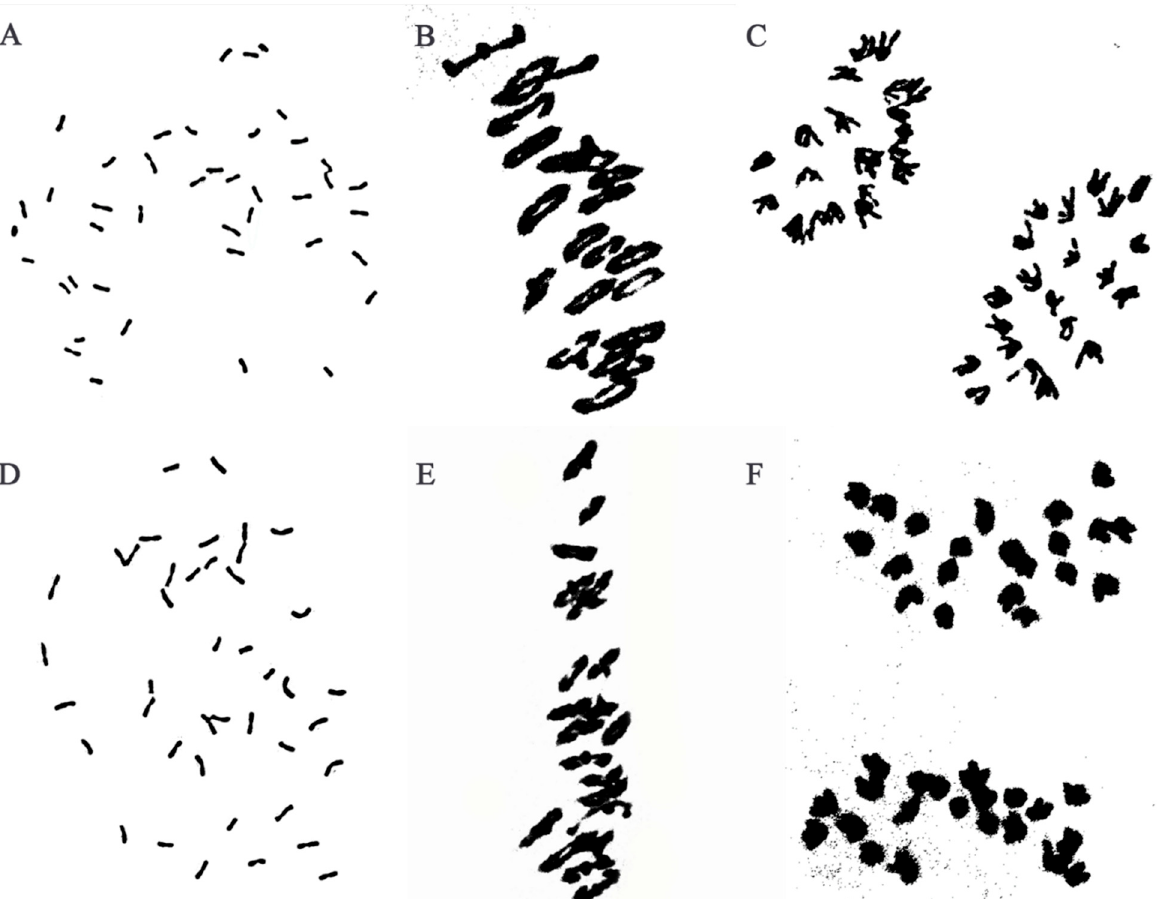
Figure 1. Cytogenetic analysis of W623 and W637. Analysis of root tip cells in W623 ( A ) and